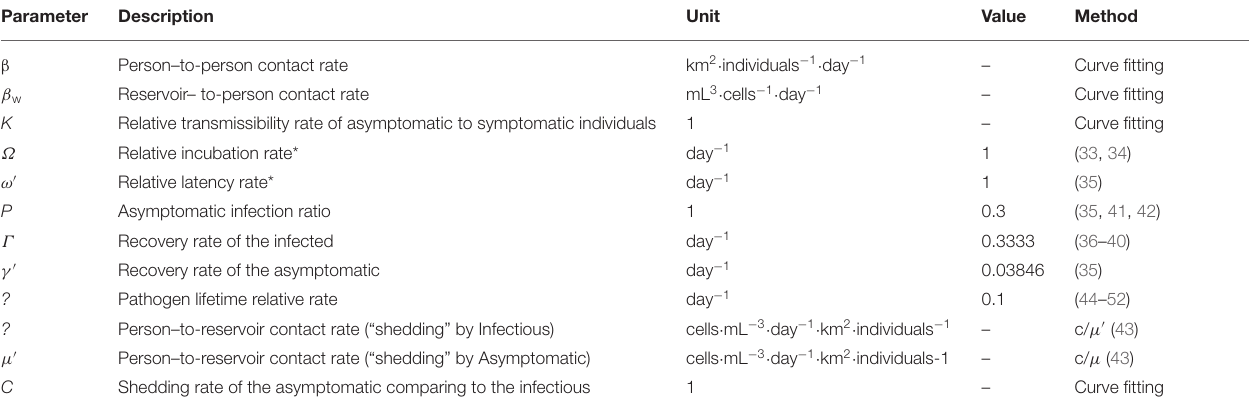
TABLE 1 | Parameter definitions and